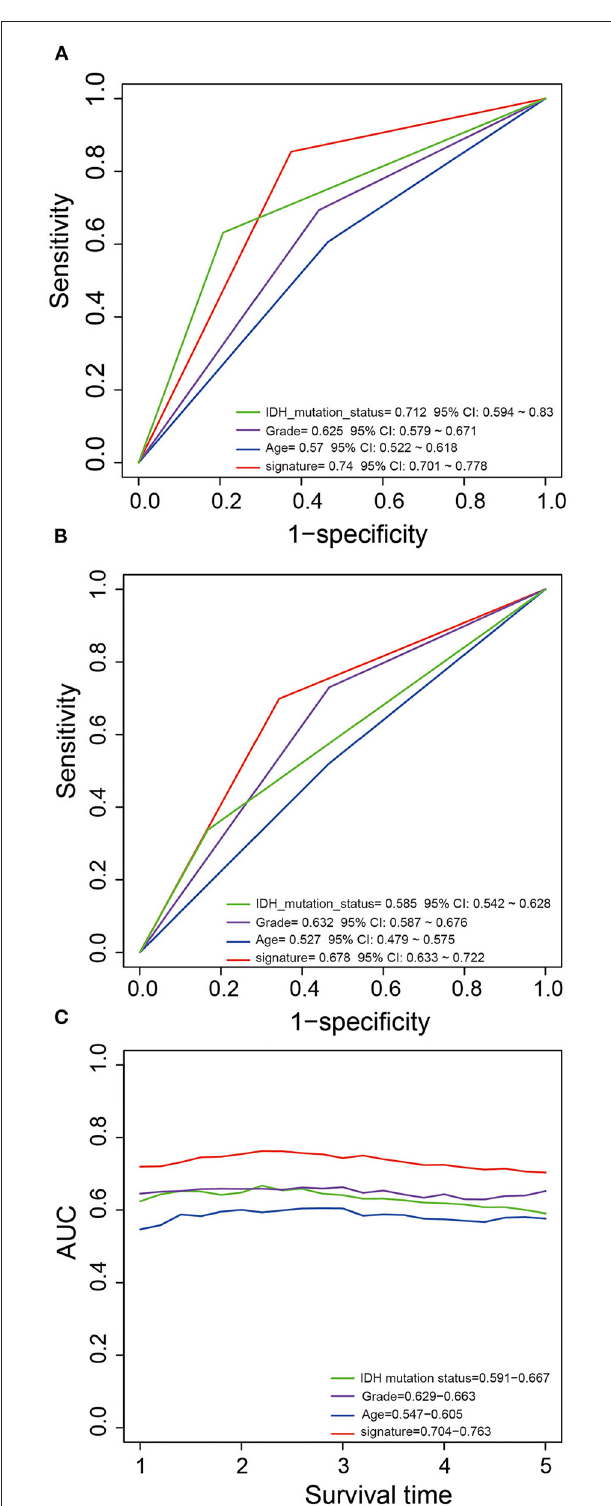
FIGURE 4 | Comparison of the survival predictive power of the signature with grade, age, and IDH mutation by ROC in the training (A) and test (B) sets. TimeROC analysis of survival predictive power for the signature, grade, age, and IDH mutation (C) .